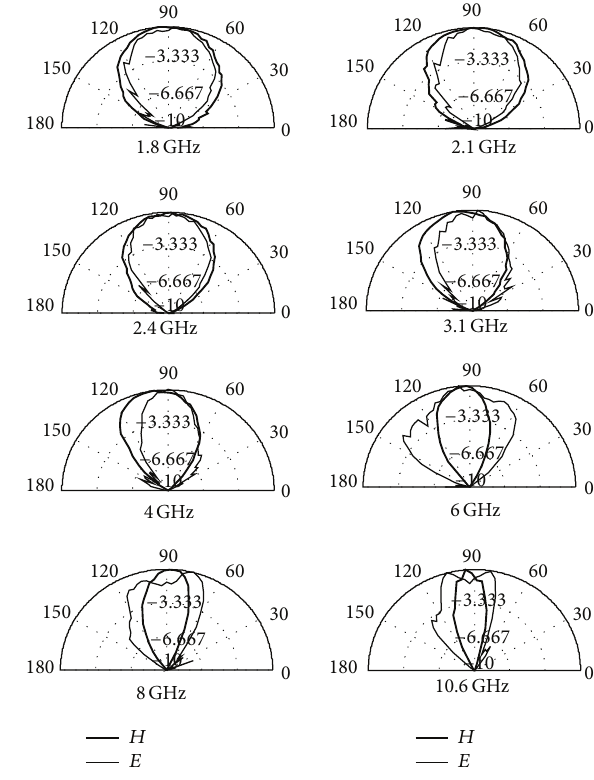
Figure 5: Measured 𝐸 -plane and 𝐻 -Plane (normalized) radiation patterns of the proposed